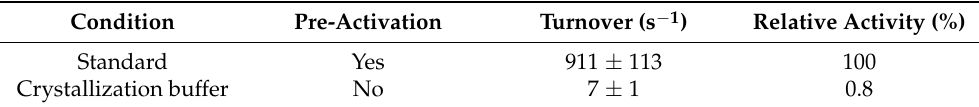
Table 1. Solution kinetic assays. Dv FdhAB kinetics under standard and crystallization conditions. Condition Pre-Activation Turnover (s − 1 ) Relative Activity (%) Standard Yes 911 ± 113 100 Crystallization buffer No 7 ± 1 0.8 Aerobically isolated and oxidized Dv FdhAB was crystallized in an anaerobic